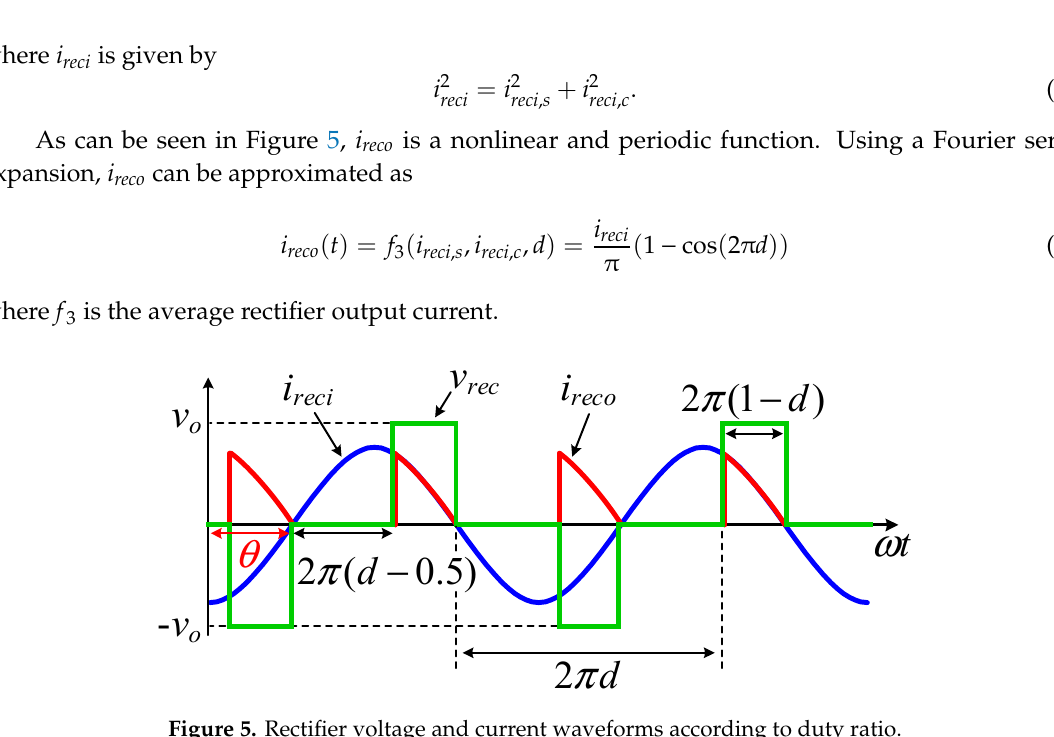
Figure 5. Rectifier voltage and current waveforms according to duty ratio.